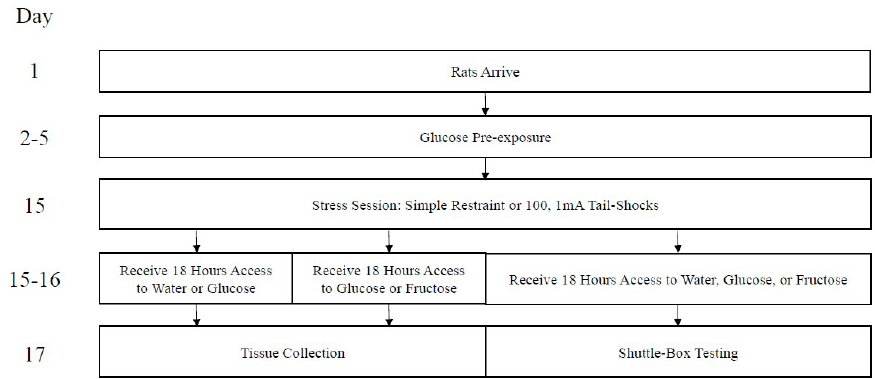
Figure 1. Timeline of events. Day 1 coincides with postnatal day (PND 50),